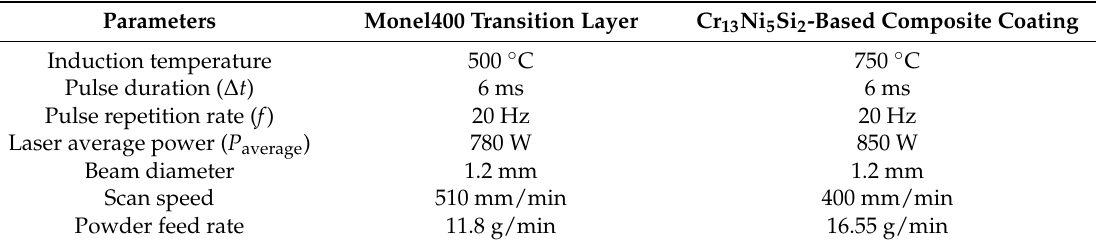
Table 1. Optimized parameters for PLIC in the